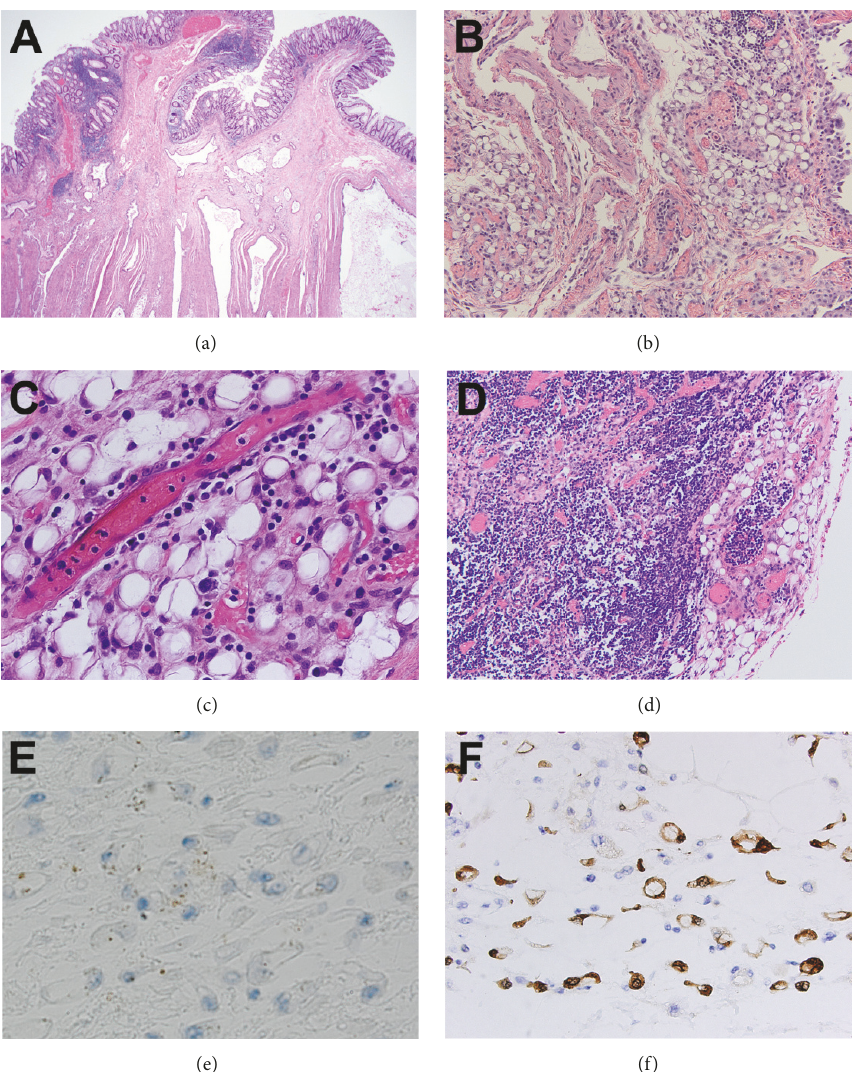
Figure 1: Dystrophic adipocytes mimicking metastatic signet ring cell adenocarcinoma in a cachectic patient. (a) Moderately differentiated adenocarcinoma invading externally into the colon at the splenic flexure with associated colonic stricture, ulceration, and mural fibrosis (hematoxylin-eosin stain, × 200). (b, c) The pericolonic tissue, mesentery, subserosa, and lymph nodes demonstrated signet ring-like cells that showed variation in size with a thickened cell membrane (hematoxylin-eosin stain, (b) × 100, (c) × 400). (d) Pericolonic lymph node demonstrated signet ring-like cells mimicking the appearance of metastatic involvement (hematoxylin-eosin stain, × 100). (e, f) Immunohistochemical staining of the signet ring-like cells demonstrates these cells to be negative for AE1/AE3 staining ((e) × 400), while being positive for S-100 staining ((f) ×